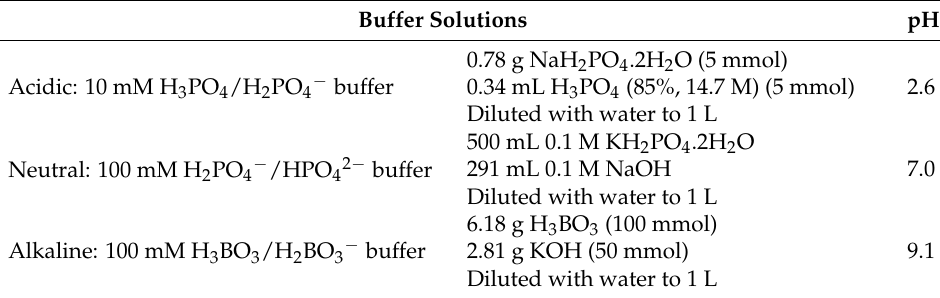
Table 1. Buffer solutions used as anolytes.